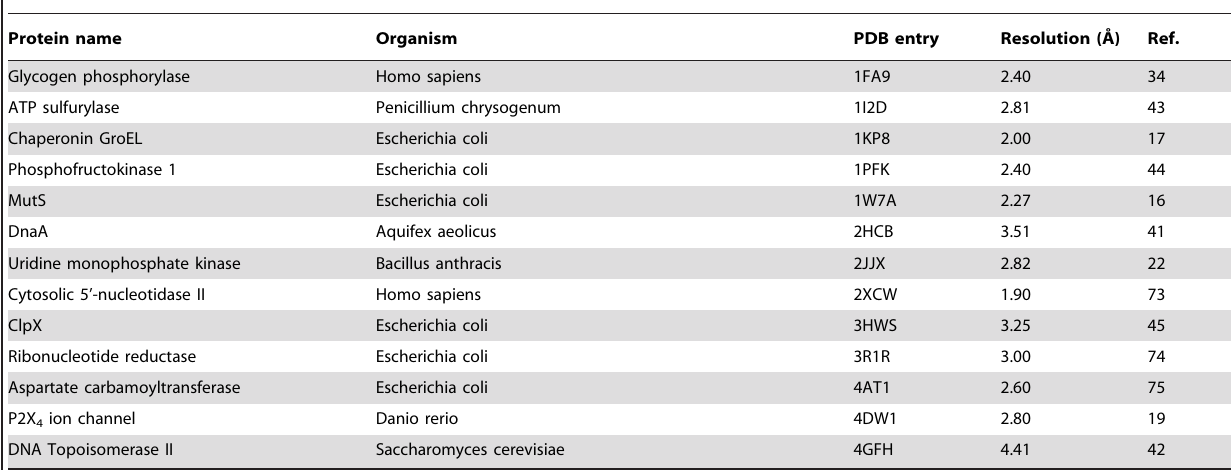
Table 1. Thirteen proteins modulated by allosteric